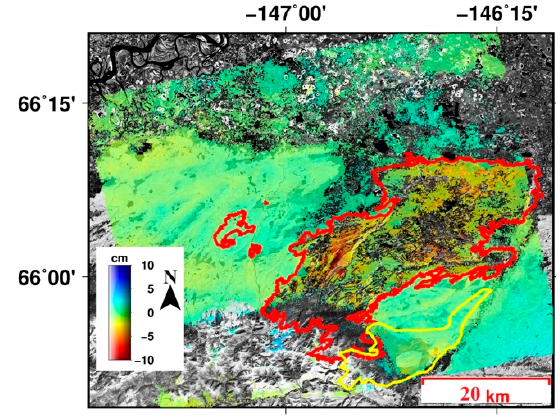
Figure 7. Mean annual deformation velocity map of track 252.